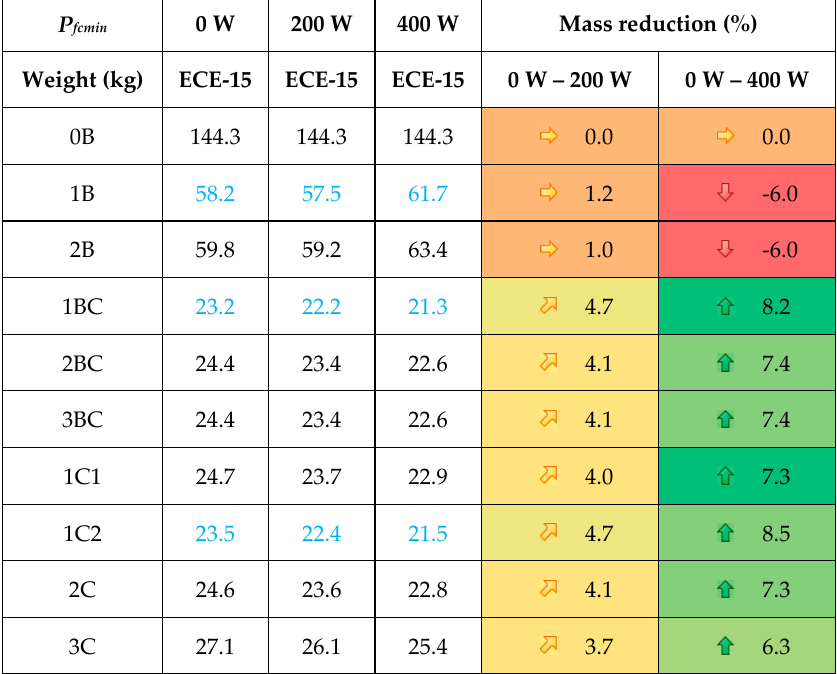
Table 3. Influence of the fuel cell minimum power on PDS mass for the ECE-15 profile.